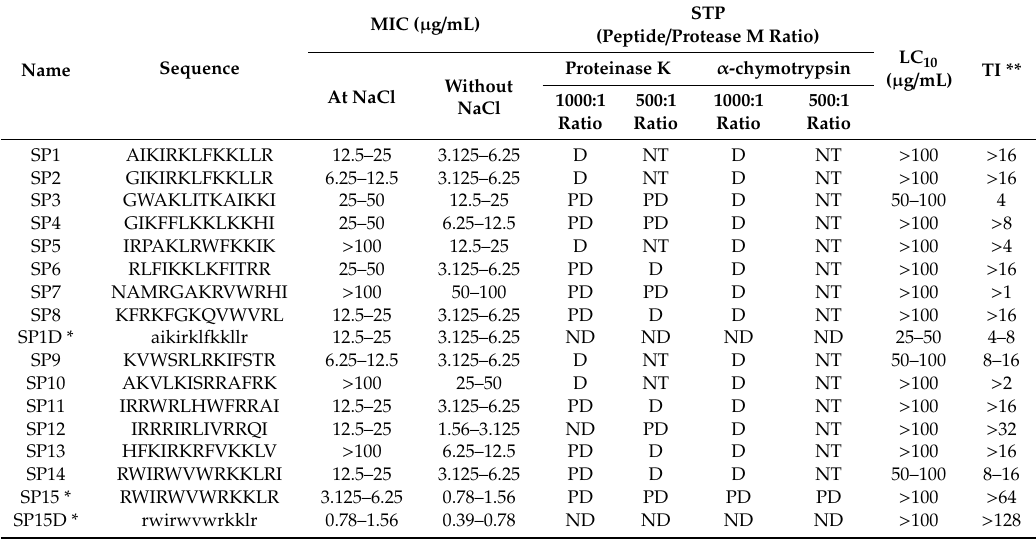
Table 3. Assessments of susceptibility of Escherichia coli ATCC 25922 (MIC), hemolytic activity (LC 10 ) proteolytic stability (STP) and therapeutic index (TI) for the designed